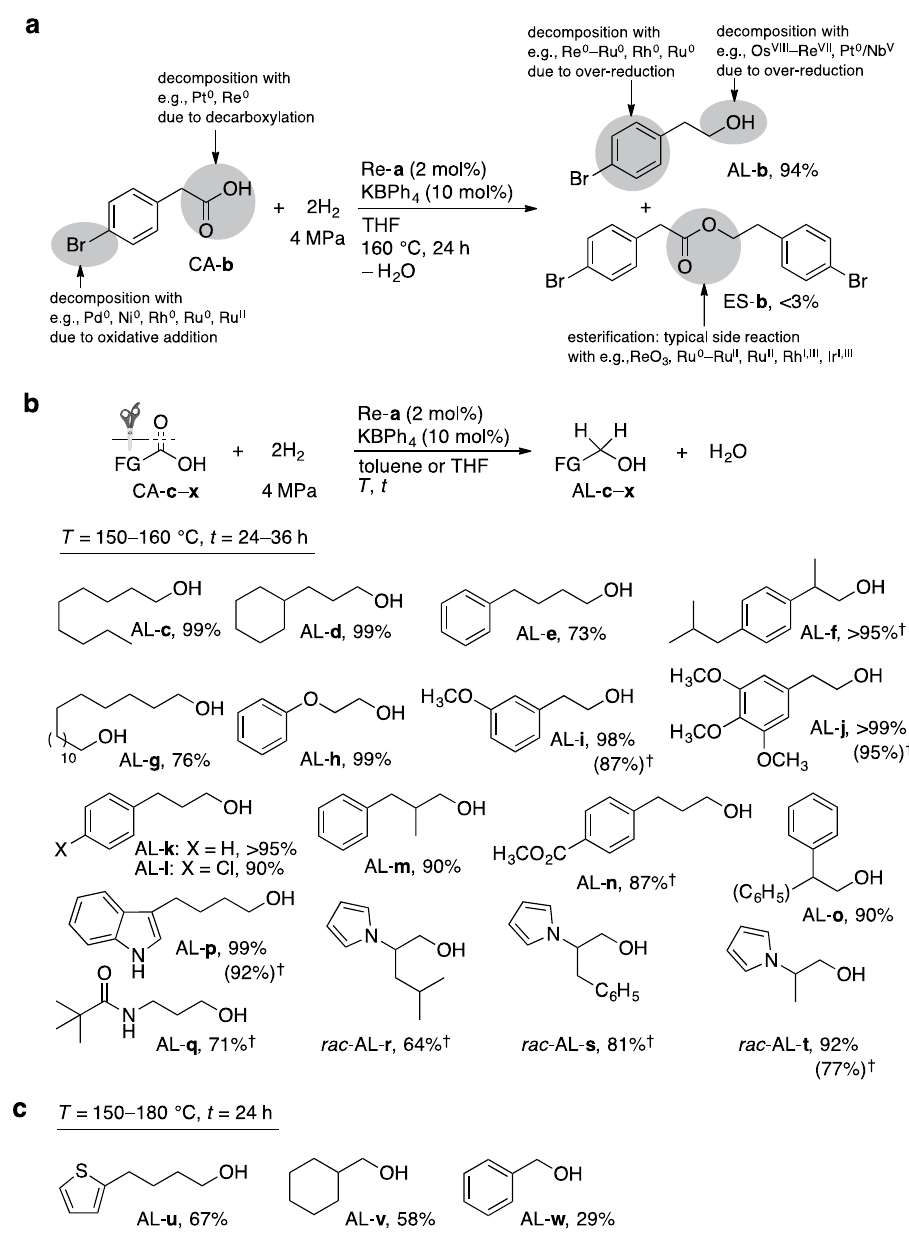
Figure 2. Catalytic hydrogenation of various CAs using Re-a. See Supplementary Tables 1–5 for experimental details. ( a ) In contrast to the low selectivity potentially obtainable with previously reported methods, hydrogenation of CA- b with Re- a afforded AL- b selectively. ( b ) CAs hydrogenated in relatively high yields. CA- g is a monocarboxylic acid, while CA- l – n are 2-enyl-1-CAs (for the exact structures, see main text. † Isolated yield. ( c ) CAs hydrogenated in lower